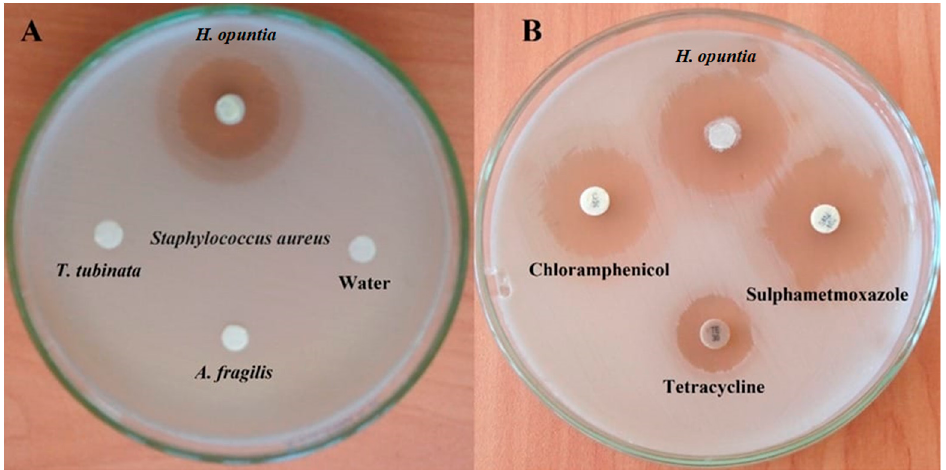
Figure 2. Antibacterial activity of lyophilized seaweed extracts ( Halimeda opuntia , Actinotrichia fragilis , and Turbinaria turbinata ) against S. aureus using agar disk diffusion assay vs. chloramphenicol, tetracycline, and sulfamethoxazole antibiotics. Inhibitions zones are measured in mm. ( A ) Antibacterial effect of three lyophilized seaweed extracts, ( B ) Antibacterial effect of antibiotics compared with H. opuntia. Table 1. Antibacterial activity and minimum inhibitory concentrations (MICs) of lyophilized sea- weeds’ extracts against S. aureus using agar disk diffusion assay.